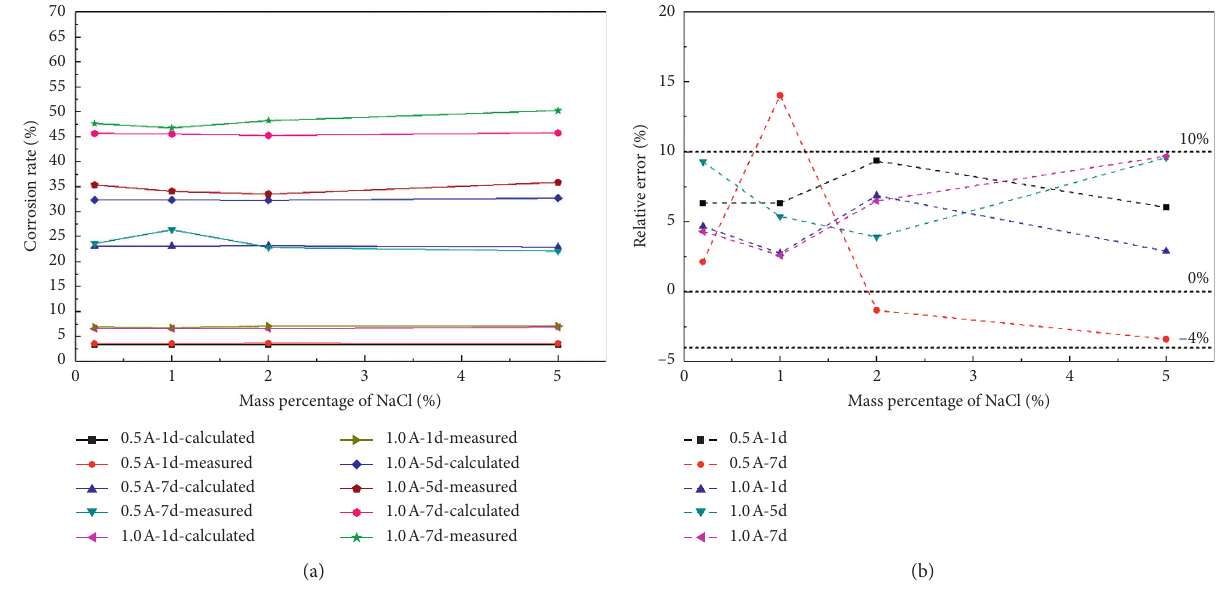
Figure 7: Corrosion rate and RE of anchor samples for different sodium chloride concentrations.